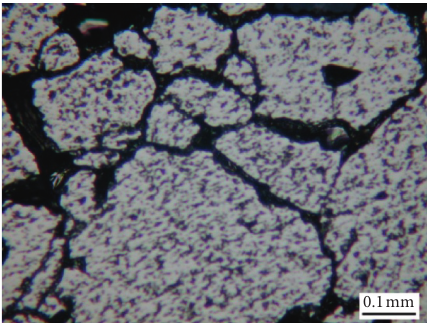
Figure 1: Typical micrograph of ore